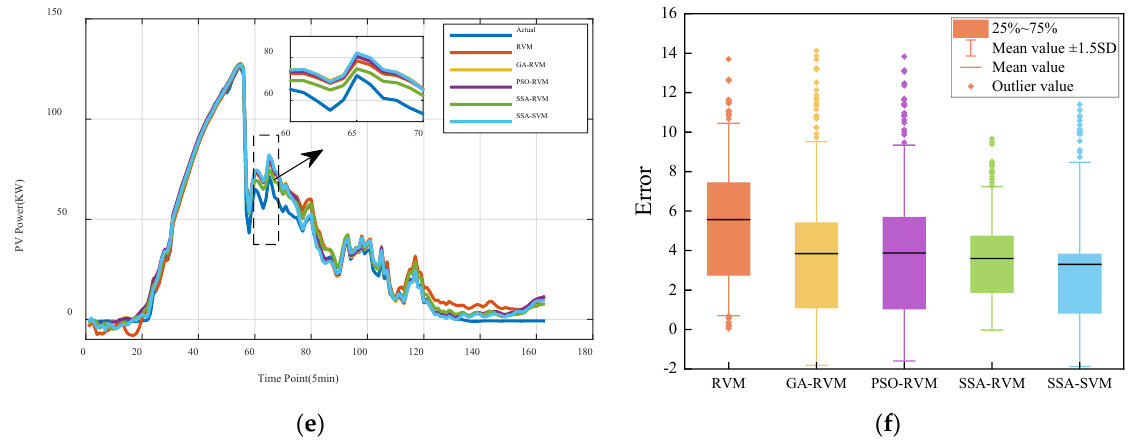
Figure 8. Results of different prediction methods under different weather types in winter: PV power prediction results in ( a )sunny, ( c ) cloudy and ( e ) rainy, forecasting error in ( b ) sunny, ( d ) cloudy, and ( f ) rainy.